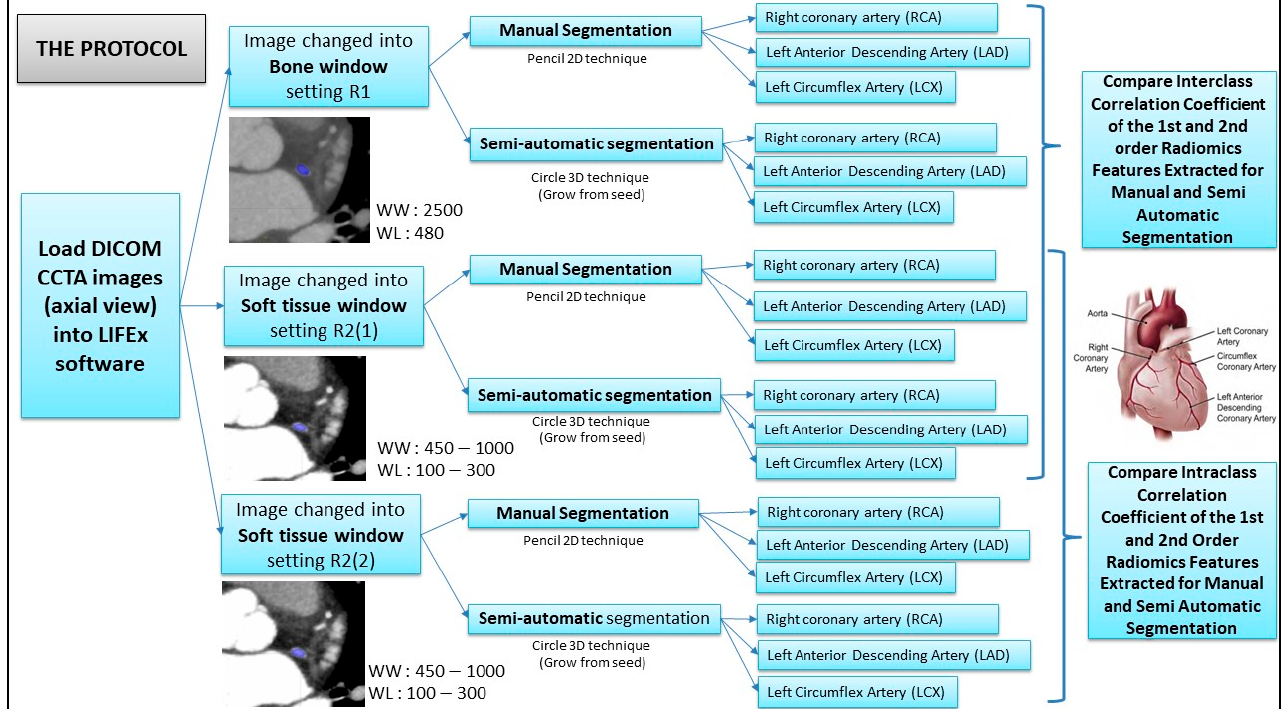
Figure 3. The framework of the research protocol.